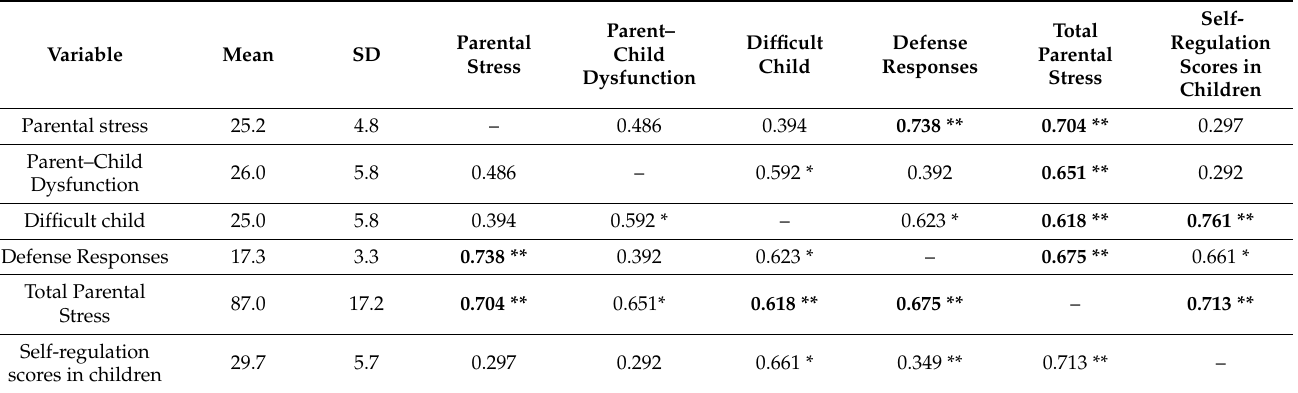
Table 2. Intercorrelations between parental stress and self-regulation problems in ASD Children (N =